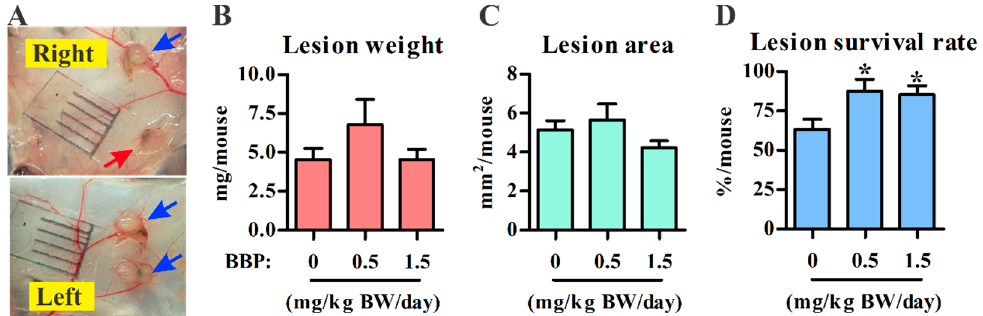
Figure 1. The effect of n-Butyl benzyl phthalate (BBP) on endometriosis development in a surgically induced model. Endometriotic lesions were harvested after 4 weeks from the surgically induced control mice (0 BBP) and from the two BBP treatment groups (0.5 and 1.5 mg BBP/kg BW/day). ( A ) The four lesions harvested from one representative control mouse. The growth lesions are identified with blue arrows, whereas the nongrowth lesion is indicated with a red arrow. ( B , C ) The mean weight ( B ) and mean area ( C ) of lesions pooled from each mouse are shown. ( D ) The lesion survival rate for each mouse was calculated from three independent experiments (control, n = 11; 0.5 mg BBP, n = 10; 1.5 mg BBP, n = 12). Results are shown as the mean ± SEM. * p < 0.05 vs. control with the Mann–Whitney U test.